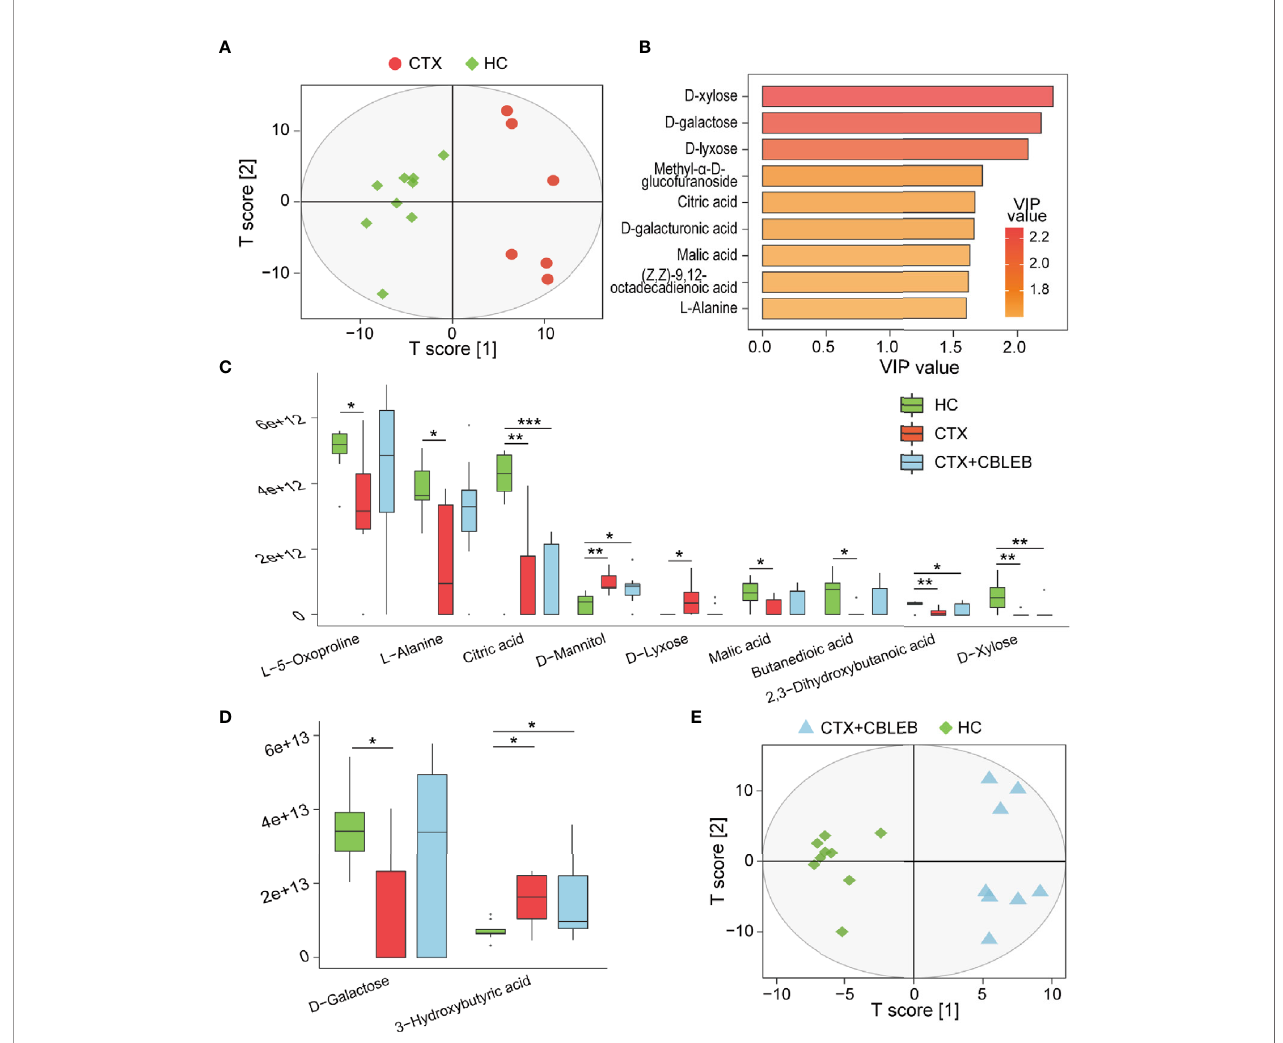
FIGURE 4 | CBLEB alleviates cyclophosphamide-induced serum metabolism disorders. (A) OPLS-DA plot illustrating clear separation of serum metabolic pro fi les of the CTX (n = 6) and HC (n = 9) groups. (B) VIP values of nine metabolites with the highest contribution to the differences between the CTX and HC groups. (C) Metabolites depleted after cyclophosphamide treatment and changes in their levels after CBLEB treatment. (D) Metabolites enriched after cyclophosphamide treatment and changes in their levels after CBLEB treatment. (E) OPLS-DA plot illustrating clear separation of serum metabolic pro fi les of the CTX+CBLEB (n = 8) and HC groups (n = 9). (* P < 0.05; ** P < 0.01; *** P <